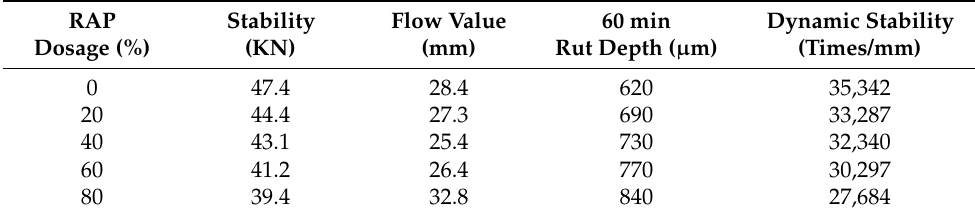
Table 7. Experimental results of high-temperature